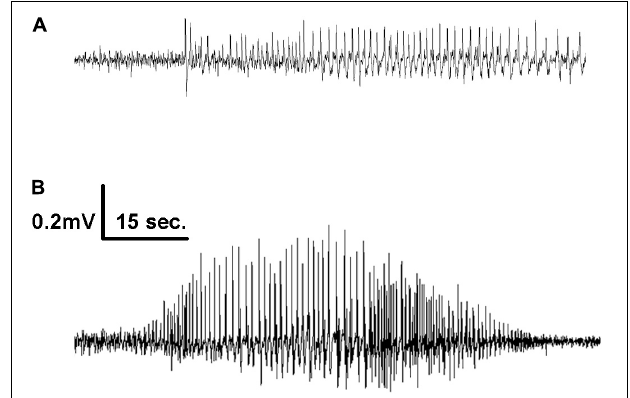
FIGURE 2 | Representative EEG tracings of electrographic seizures recorded from the frontal cortex of mice infused with 1X (A) and 10X (B) 2G6 monoclonal anti-NMDAR